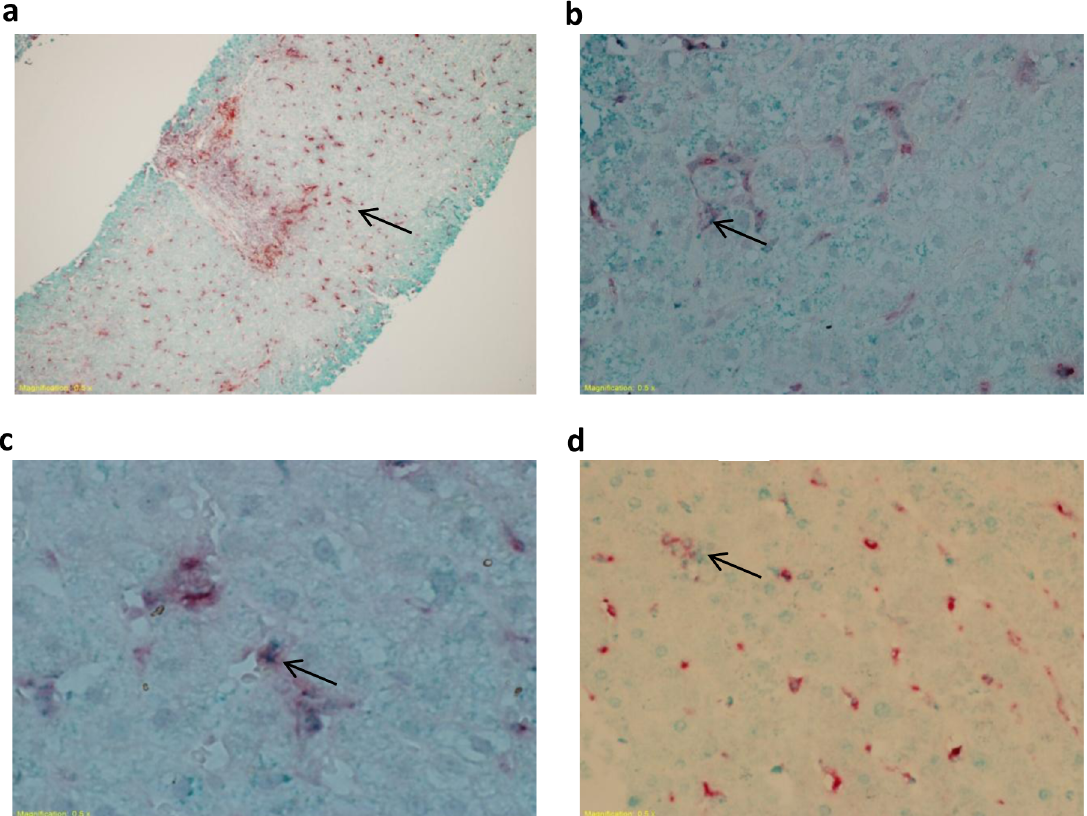
Fig 1. CD68, CD80, CD86 and PD-L1 staining in liver biopsies. Biopsies from HBV-infected and control individuals were stained with mouse anti-human CD68 and rabbit anti-human CD80, CD86 or PD-L1 Abs. Representative photomicrographs showing ( A ) CD68 red staining indicating CD68 + cells and ( B-D ) CD80, CD86 or PD-L1 green staining observed as dots within the red stained cells indicating CD68 + CD80 + , CD68 + CD86 + and CD68 + PD-L1 + cells. This figure is also used in a related article about the expression of CD80, CD86 and PD-L1 in liver CD68 + cells during chronic HCV infection (the same control group was used in both studies that were conducted in parallel)